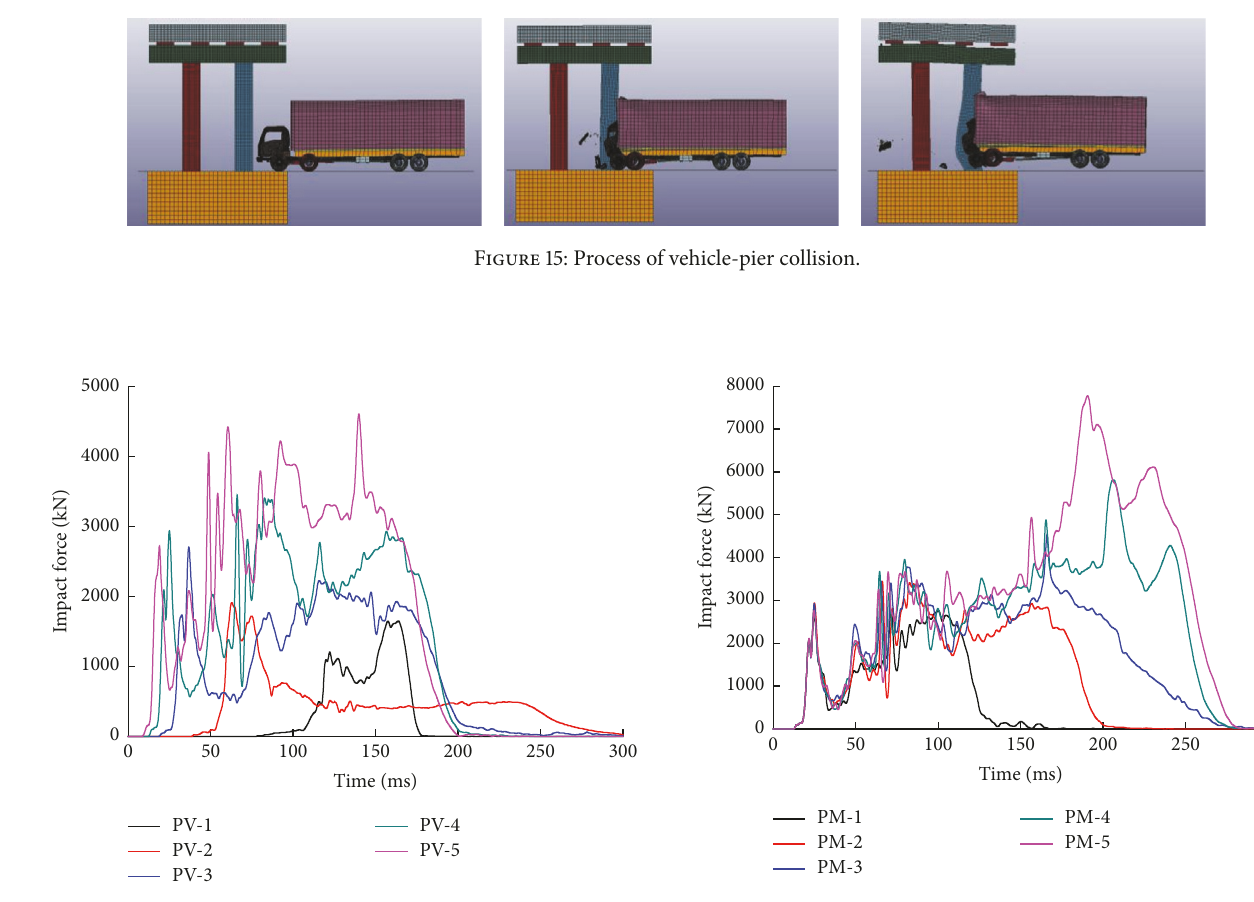
Figure 18: Impact force time-history curves under different impact masses.